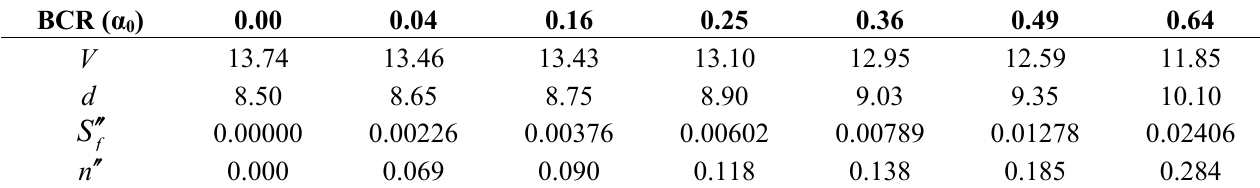
Table 2. Water depths in different BCRs (unit: